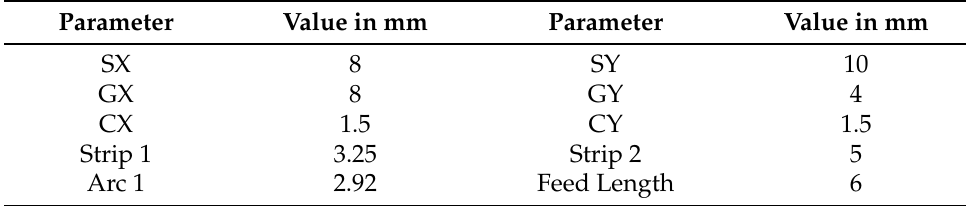
Figure 1. Proposed antenna design: ( a ) front view; and ( b ) back view. Table 1. Design